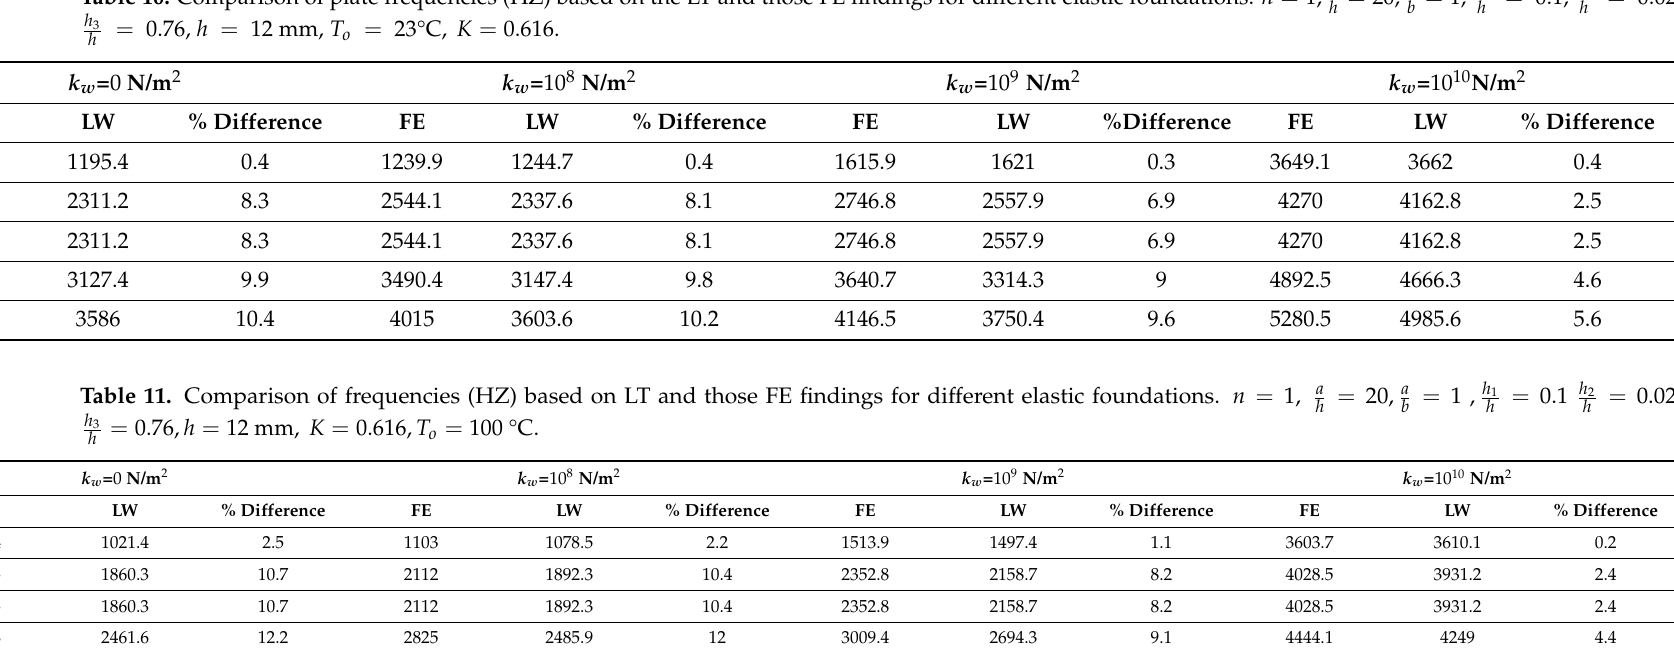
= 20, a = 1, h 1 = 0.1, h 2 = 0.02, h b h h